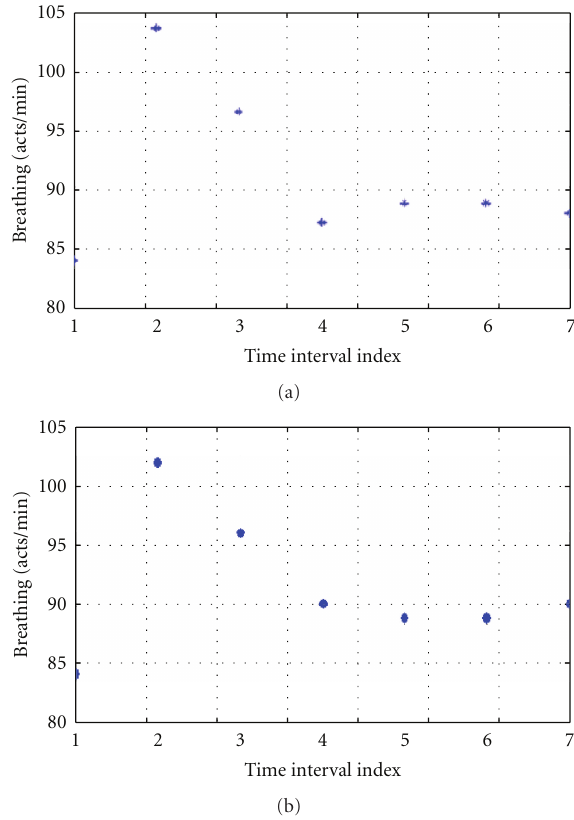
Figure 8: Comparison between the data-processing approaches for the heartbeat activity: (a) (upper) first data-processing approach; (b) (lower) second data-processing